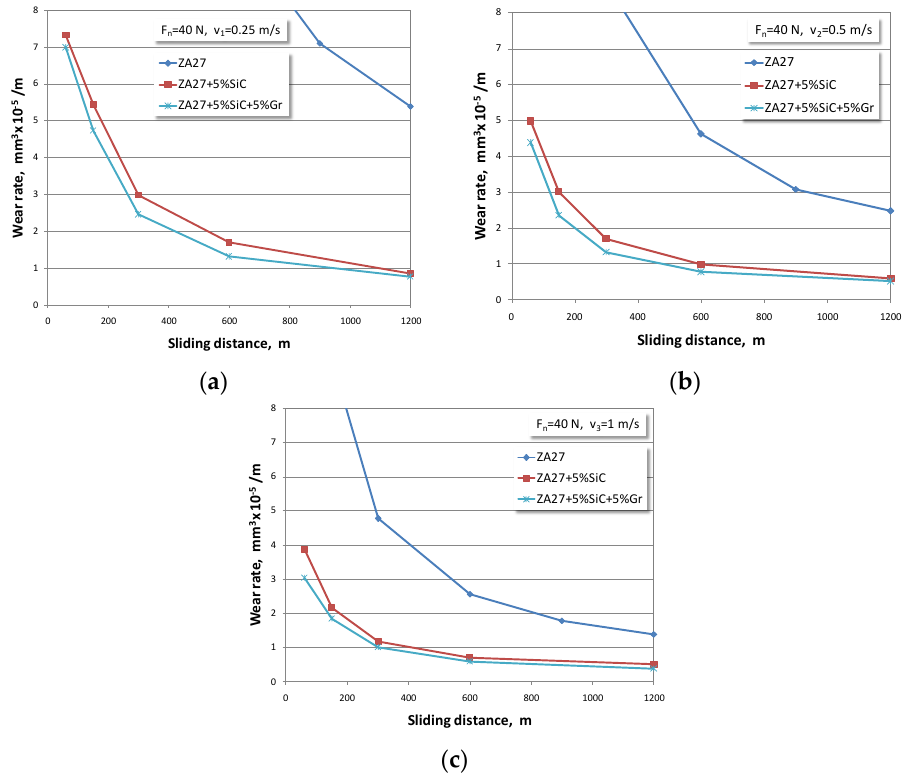
Figure 3. Wear rates for normal load of 40 N and sliding speeds of: ( a ) v = 0.25m/s; ( b ) v = 0.5m/s; ( c ) v = 1 m/s.